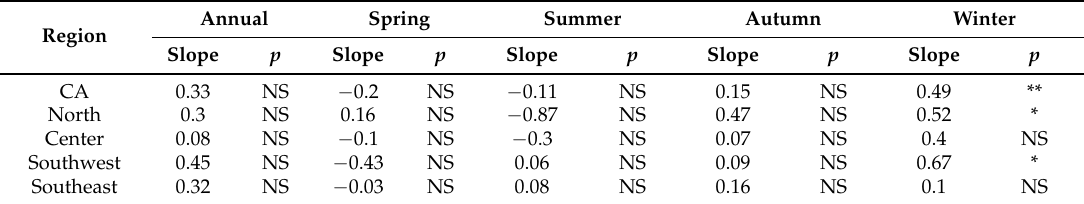
Figure 5. Variations in precipitation (mm/year) of Central Asia (CA) and four subregions from 1960–1991. ( a ) Annual; ( b ) Winter. Table 2. Trends in annual and seasonal precipitation (mm/year) for Central Asia (CA) and four subregions from 1960–1991.